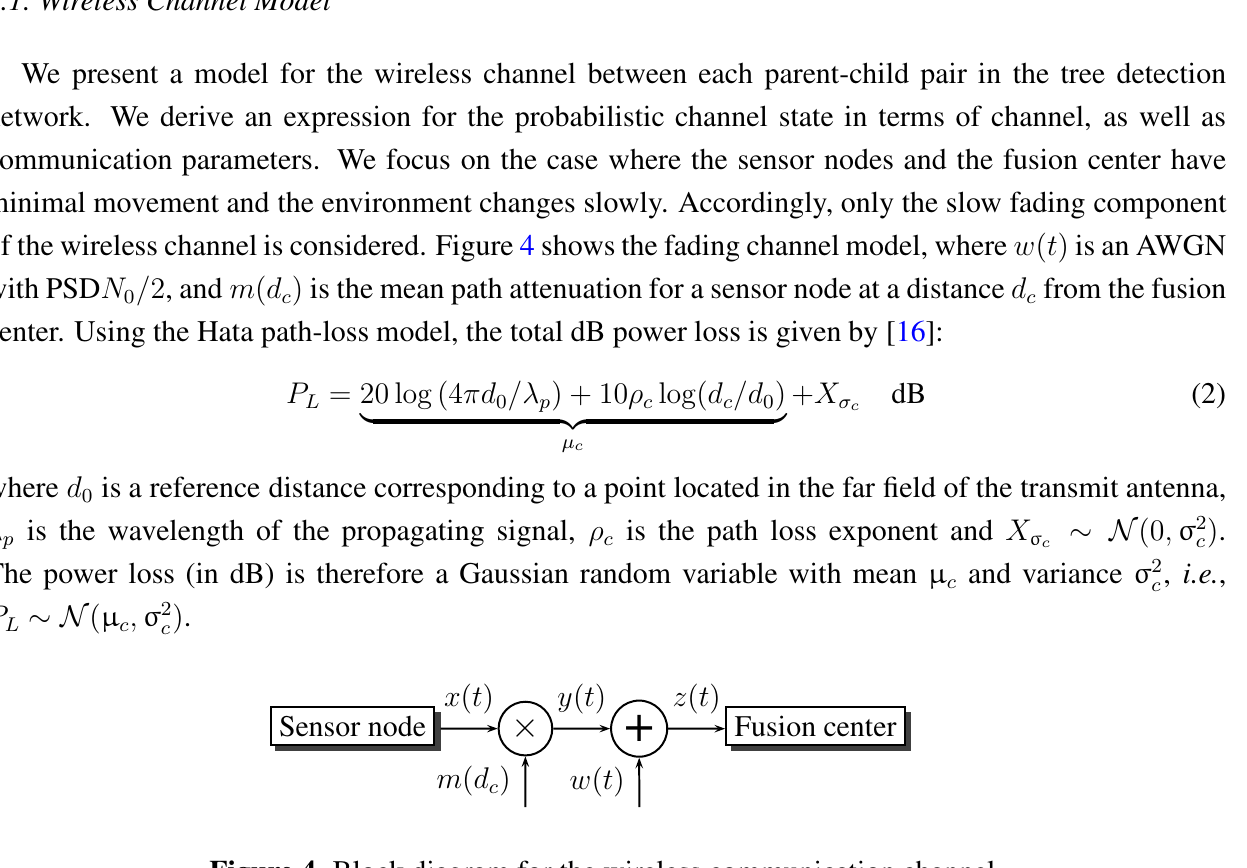
Figure 4. Block diagram for the wireless communication